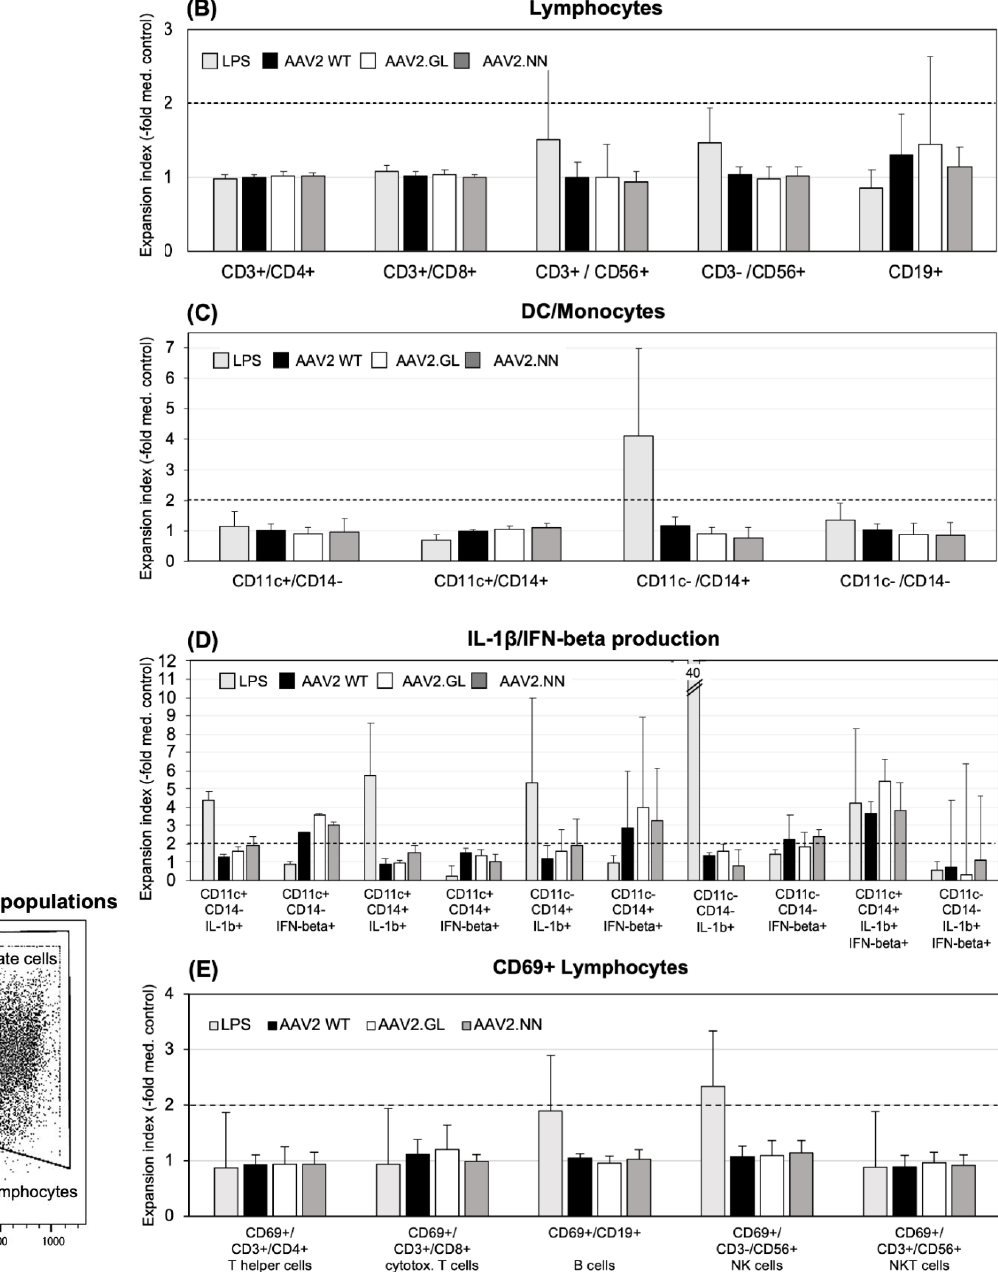
Figure 3. Expansion of cell populations after in vitro stimulation with AAV vectors. ( A ) Cells were gated for FACScan analysis according to FSC (forward scatter) and SSC (side scatter) in the “innate cells” population including monocytes/macrophages, DCs and granulocytes, and “lymphocytes”, including B, T, and NK/NKT cells (see the Materials and Methods section for more details). ( B ) CD3+ T cells (CD4+ Th, CD8+ cytotoxic T and CD56+ NK-T cells, CD3-CD56+ NK cells, and CD19+ T cells were analyzed from the lymphocyte gate. ( C ) CD11c+/CD14- DCs, CD11c+/CD14+ monocyte-derived DCs, and CD11c-/CD14+ monocytes were analyzed from the “innate cells” gate. ( D ) Surface staining for DCs and monocytes was combined with cytoplasmic staining for IL-1 β and IFN-beta, respectively. The y-axis is cut at an expansion index of 12, as well as the expansion index of 40 from the LPS-simulated cells, and the CD11c-/CD14-/IL1 β + population is indicated in the respective column. ( E ) CD69-expressing lymphocyte subpopulations. The shown data are the means ± SD of the “expansion index” calculated as fold of the population size calculated from the population in the medium control. The results are shown as the mean expansion index of all tested donors ( n = 6) after 24 h of in vitro stimulation, which was determined as the optimal time point from different